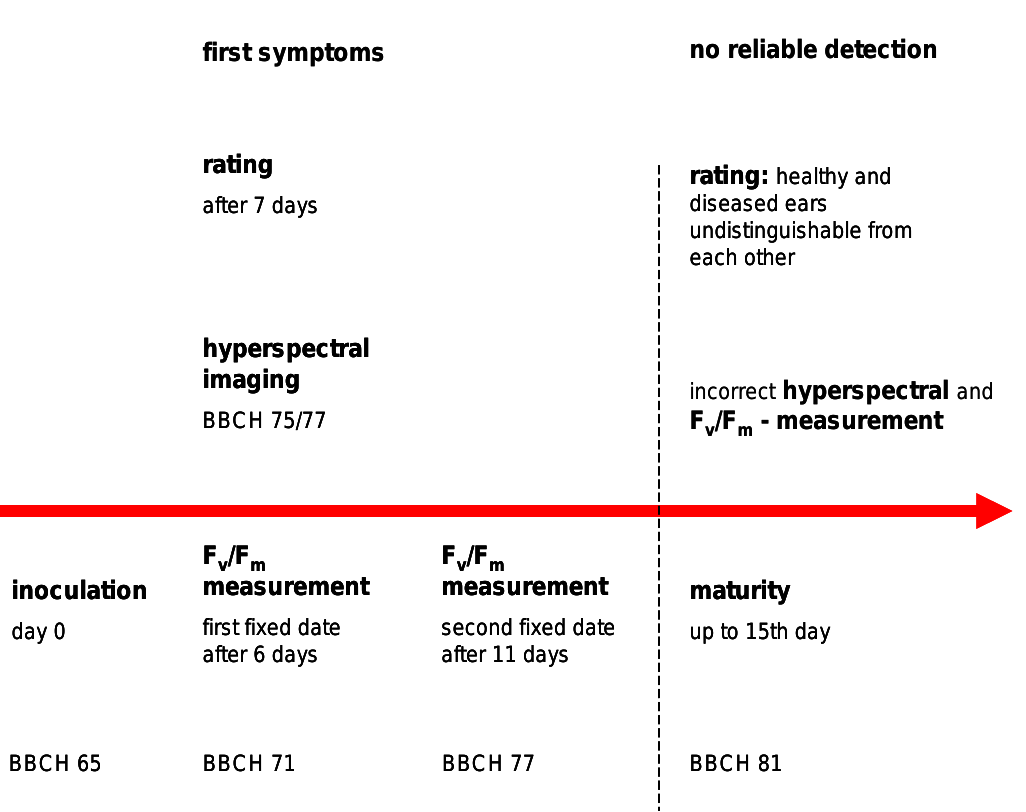
Figure 7. Time bar for the detection of head blight under indoor